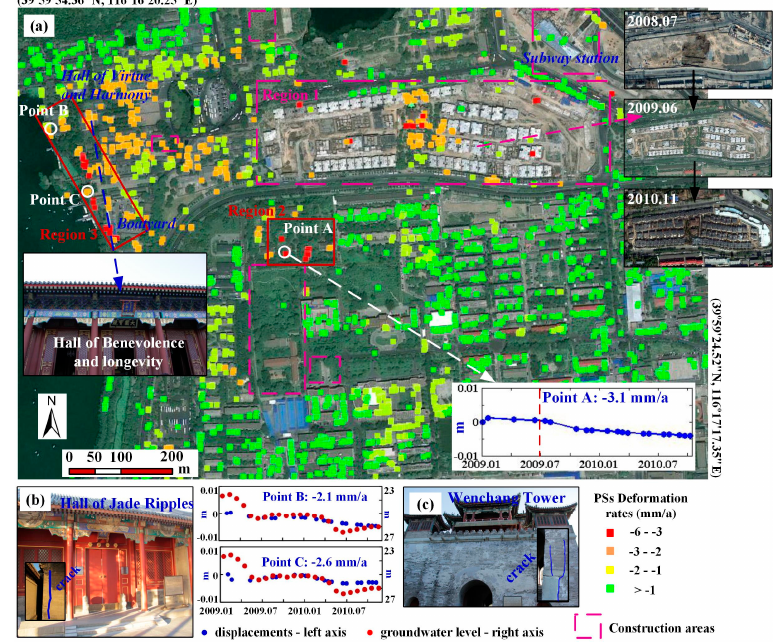
Figure 7. ( a ) Map of deformation rates in the East Gate region superimposed on the Google Earth image acquired in June 2009. Constructions during 2009–2010 and their impacted neighborhoods are marked as pink and red dashed-boxes; ( b , c ) Photographs of Points B and C, respectively. The graphs illustrate the displacement evolution (blue dots) of Points A–C. The red dashed line in the evolution of Point A was used to mark the starting time of the construction activity in the south. Groundwater data (red dots) were used to validate the displacement evolution of Points B and C.